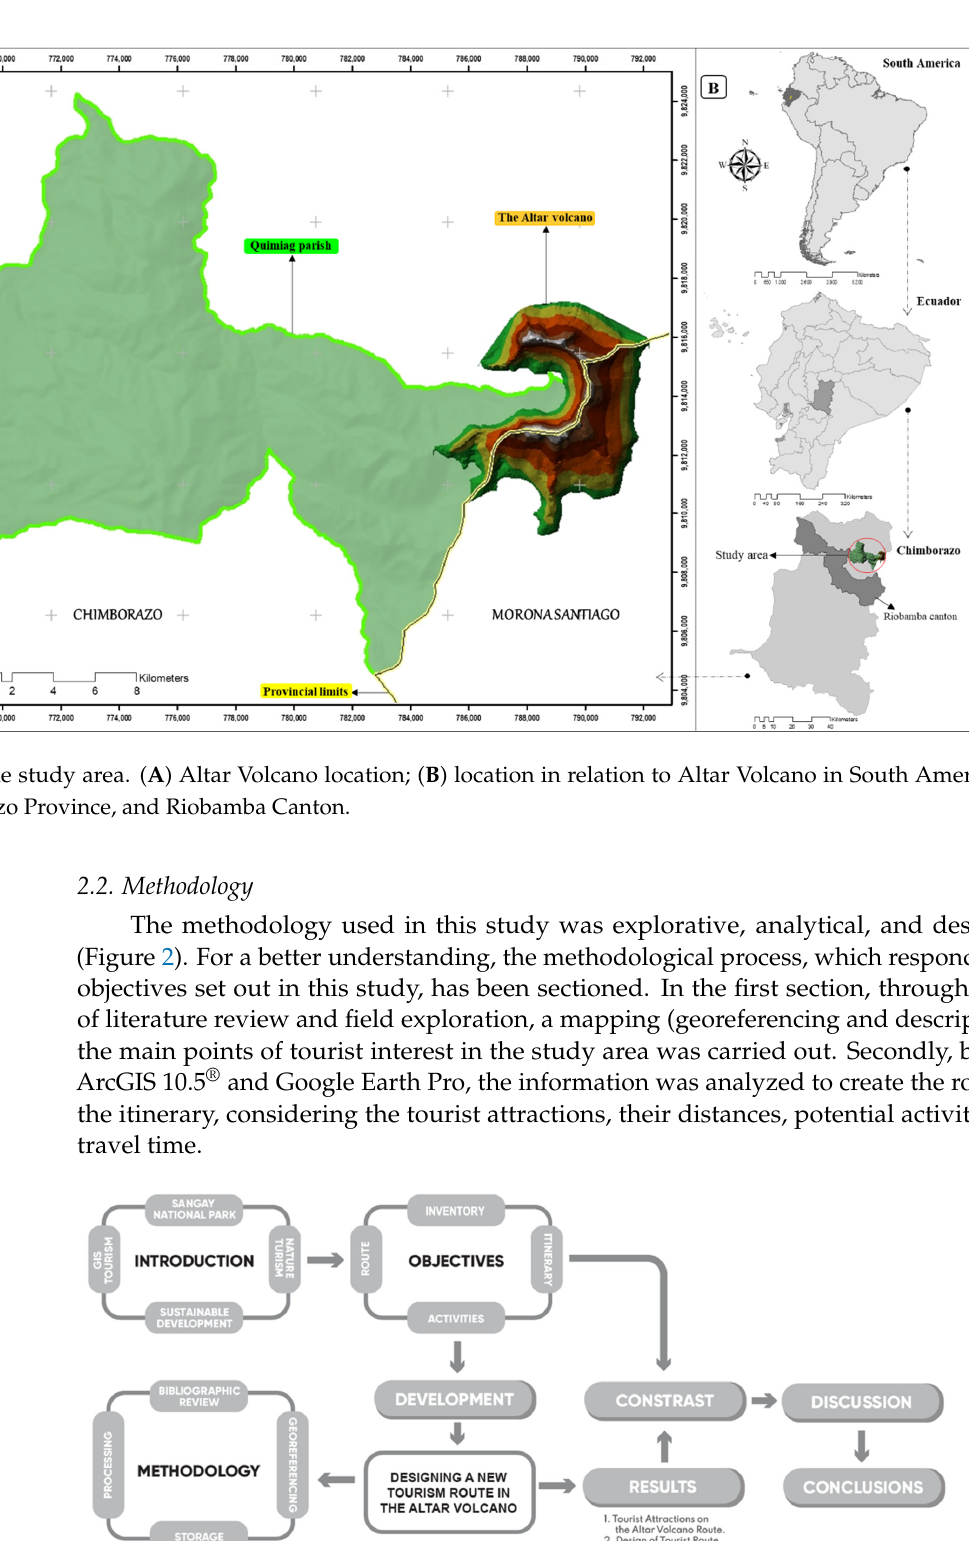
Figure 2. Methodological research process.